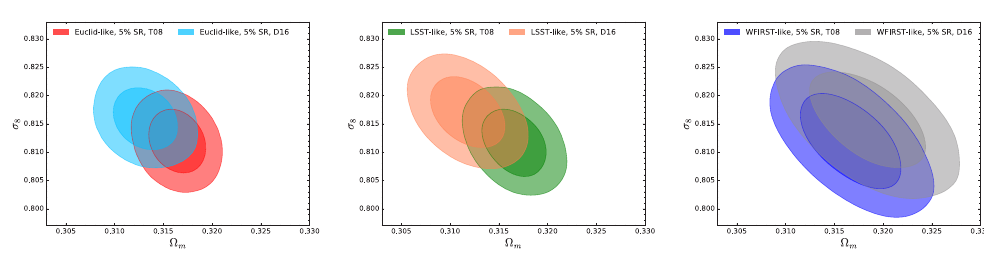
Figure 3. Two-dimensional probability distributions in ( Ω m σ 8 ) parameter plane for the Euclid-like, LSST-like and WFIRST-like experiments. These plots are taken from Figure 2. Evolution of the mass bias with respect to redshift, at fixed values of mass, for di ff erent dataset combination. We compare results for the full Planck cosmological sample (left panel), with results obtained when selecting clusters with z 0 . 2 (right panel). These plots are taken from [15]. ≥